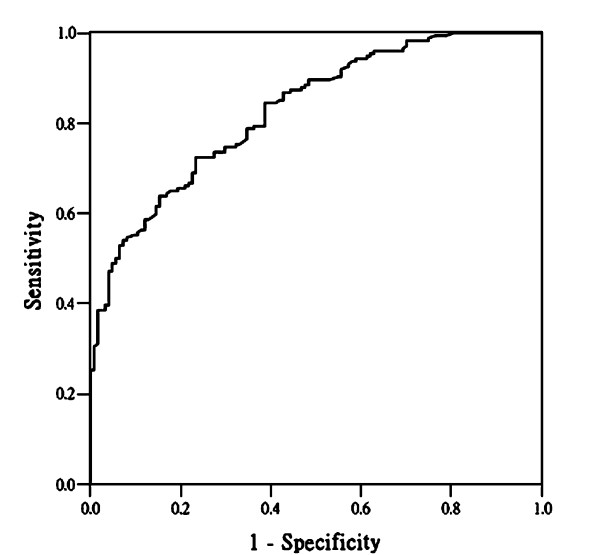
The ROC of an age-adjusted multivariate regression model. AUC = 0.828.